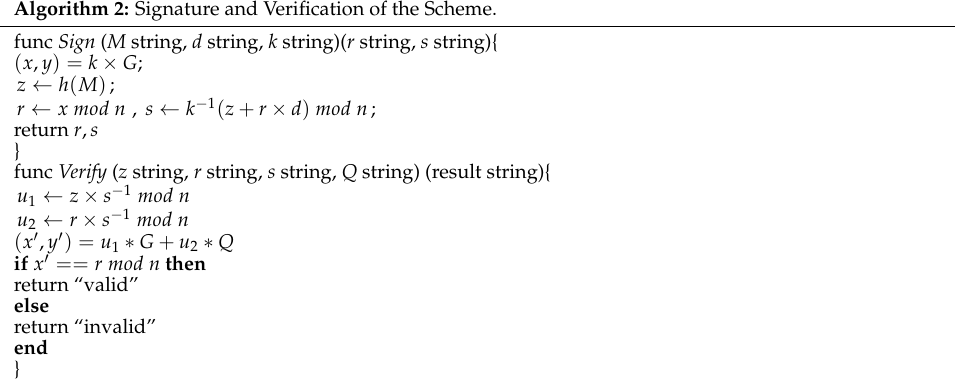
Algorithm 2: Signature and Verification of the